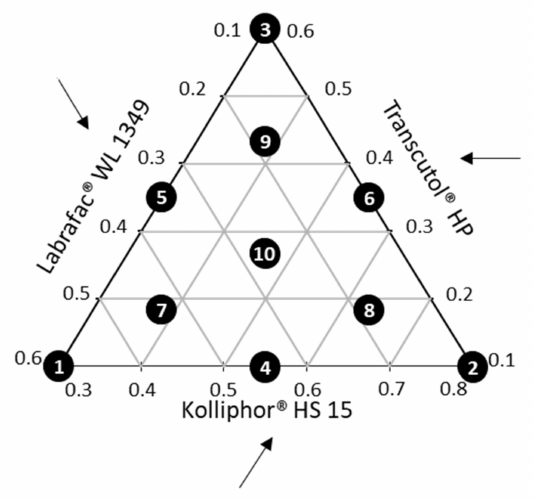
Figure 1. Ternary diagram for the mixture design: the central point (point 10) was